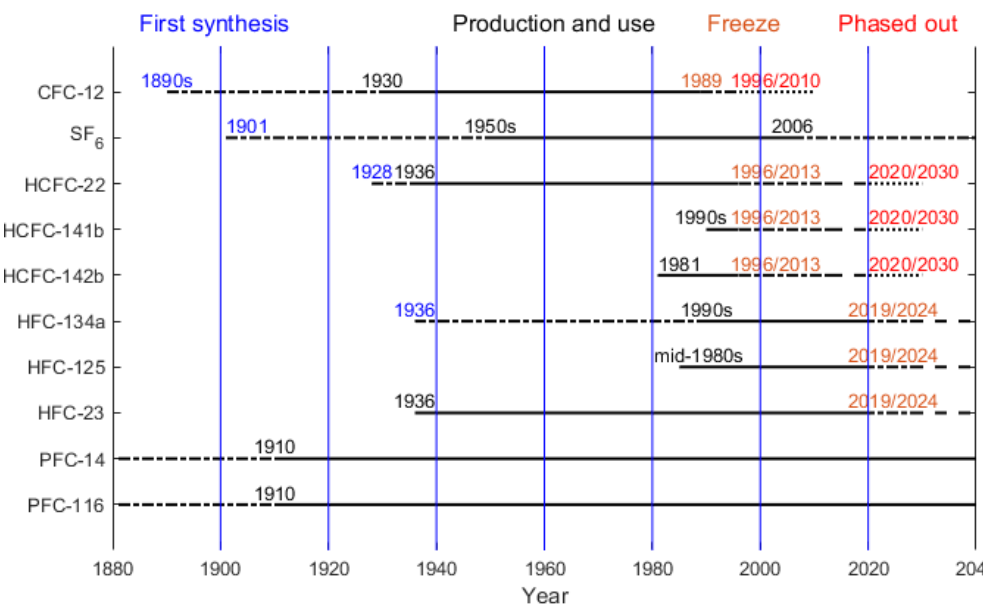
Figure 1. Comparison of production and use histories of CFC-12, SF 6 , HCFCs, HFCs and